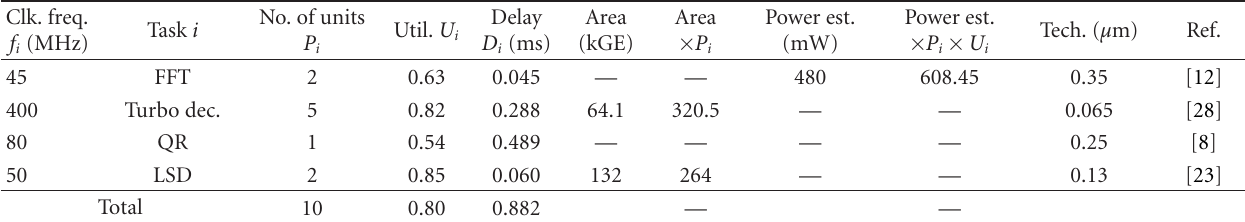
Table 3: An example baseband processing chain with 4 × 4 antennas, 601 subcarriers, 16-QAM, 4808-length turbo code block, list length K = 10, data rate 68 Mbps.